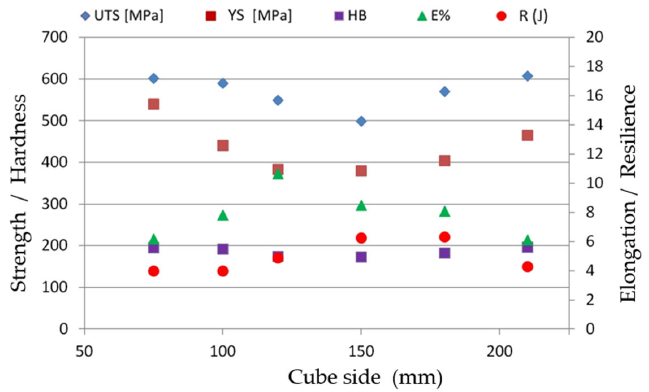
Figure 8. Average mechanical properties of specimens from the same cube side.